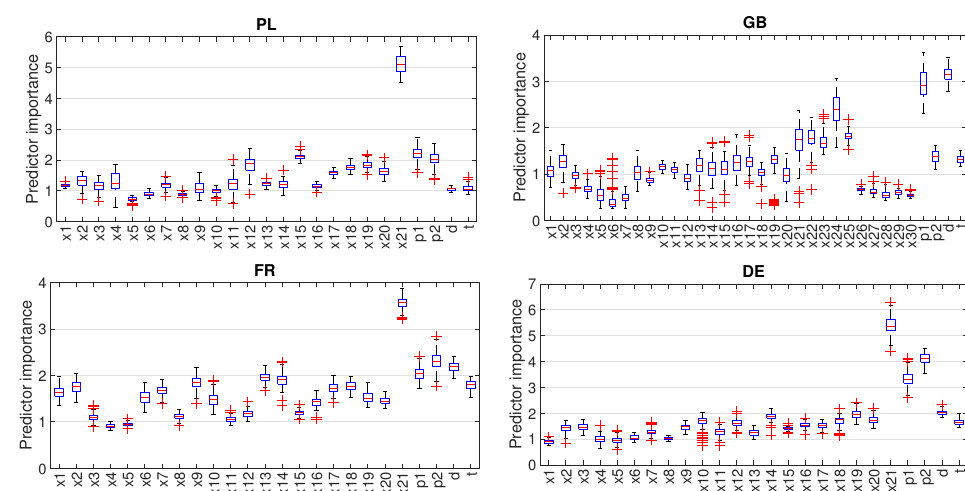
Figure 8. Importance of the predictors ( x 1 − x 30—predictors expressing demand pattern r4 or r6, p 1 and p 2—components of vector p expressing season of the year, d —day of the week, and t —hour of the day).